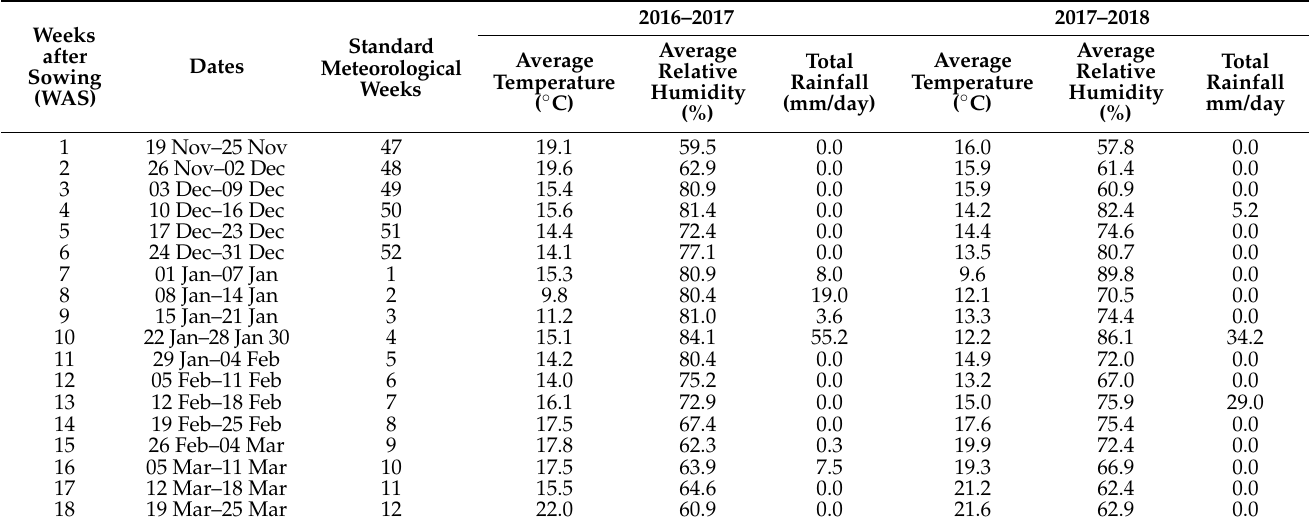
Table 1. Weather parameters recorded at the experimental site during 2016–2017 and 2017–2018. (Nov = November, Dec = December, Jan = January, Feb = February, Mar =